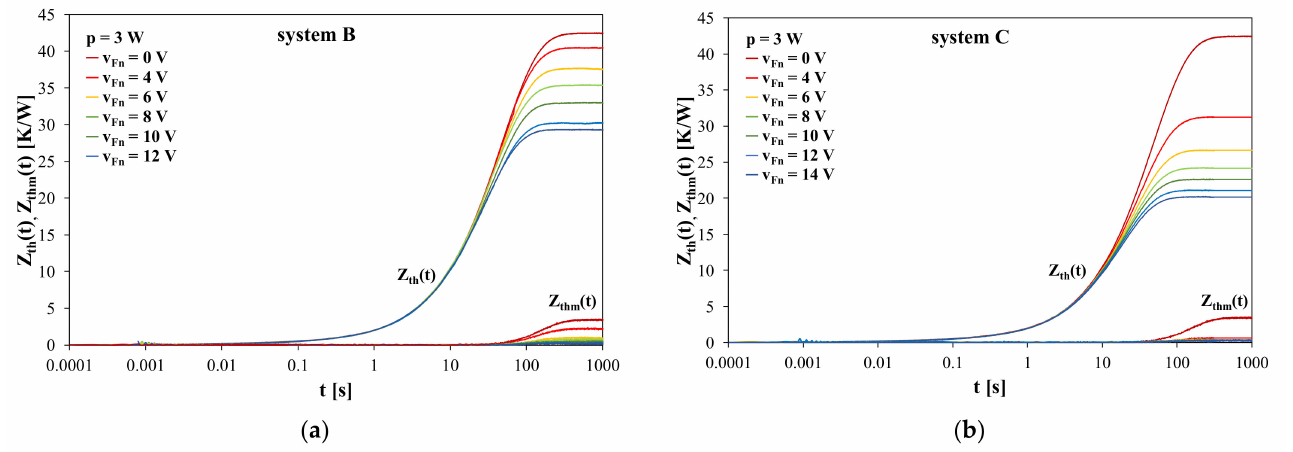
Figure 12. Transient thermal impedances Z th (t) and Z thm (t) of the investigated MOSFETs with the cooling system ( a ) B and ( b )